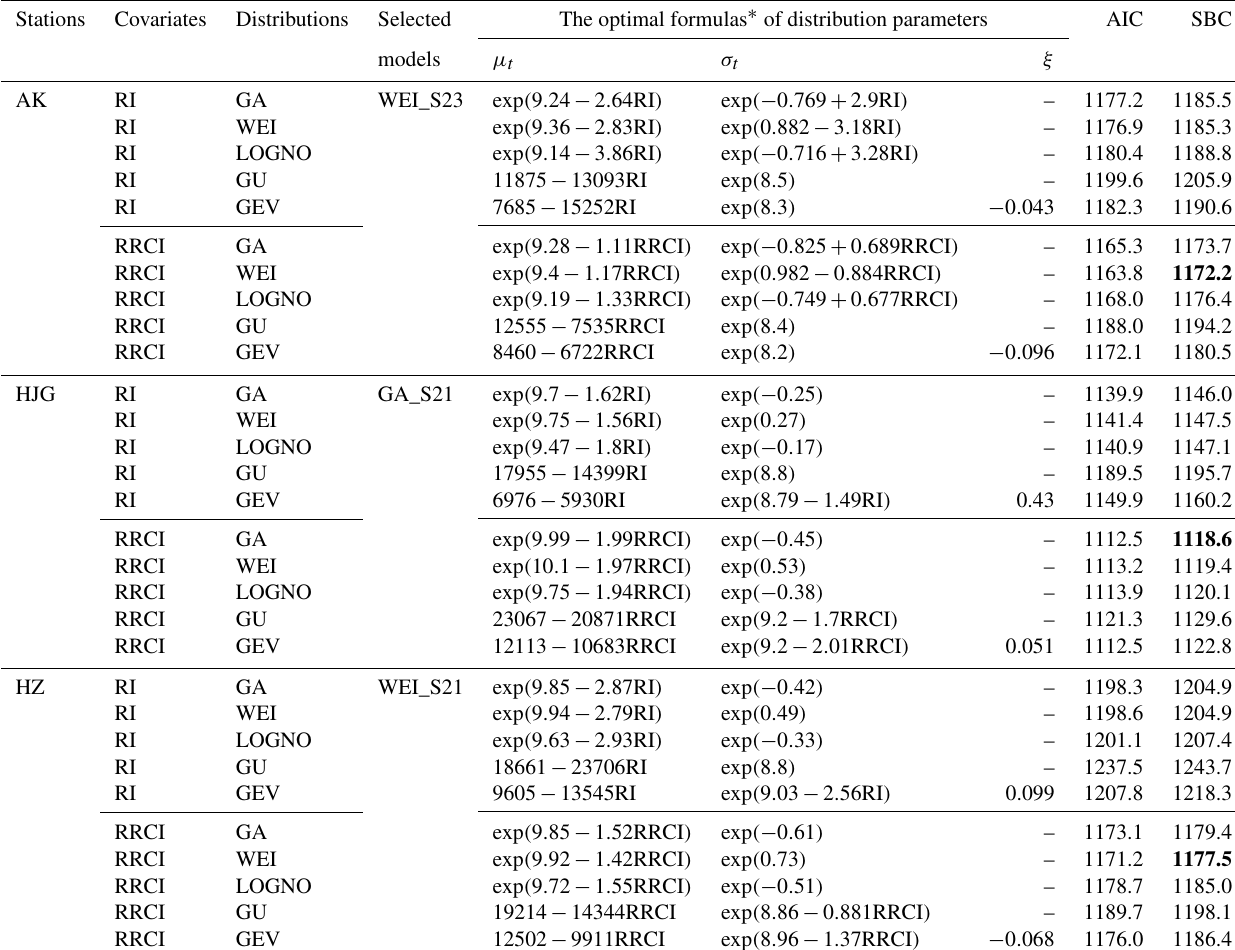
Table 7. Summary of the results of the nonstationary flood distribution models. The value in bold font is the lowest SBC value for the station. Stations